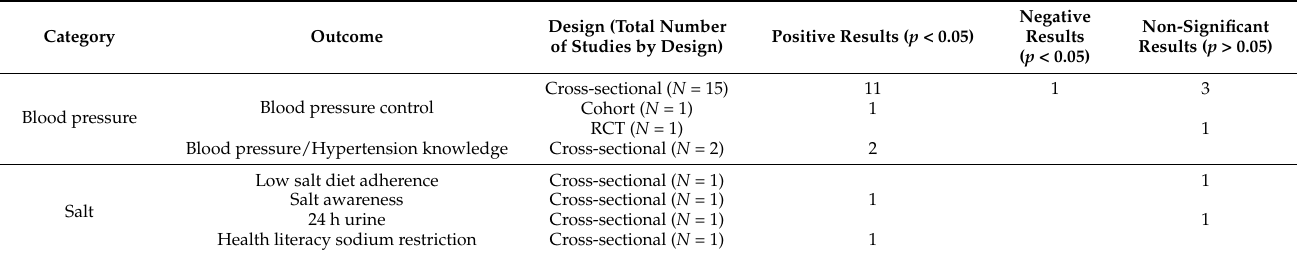
Table 7. Health literacy and outcomes: summary of